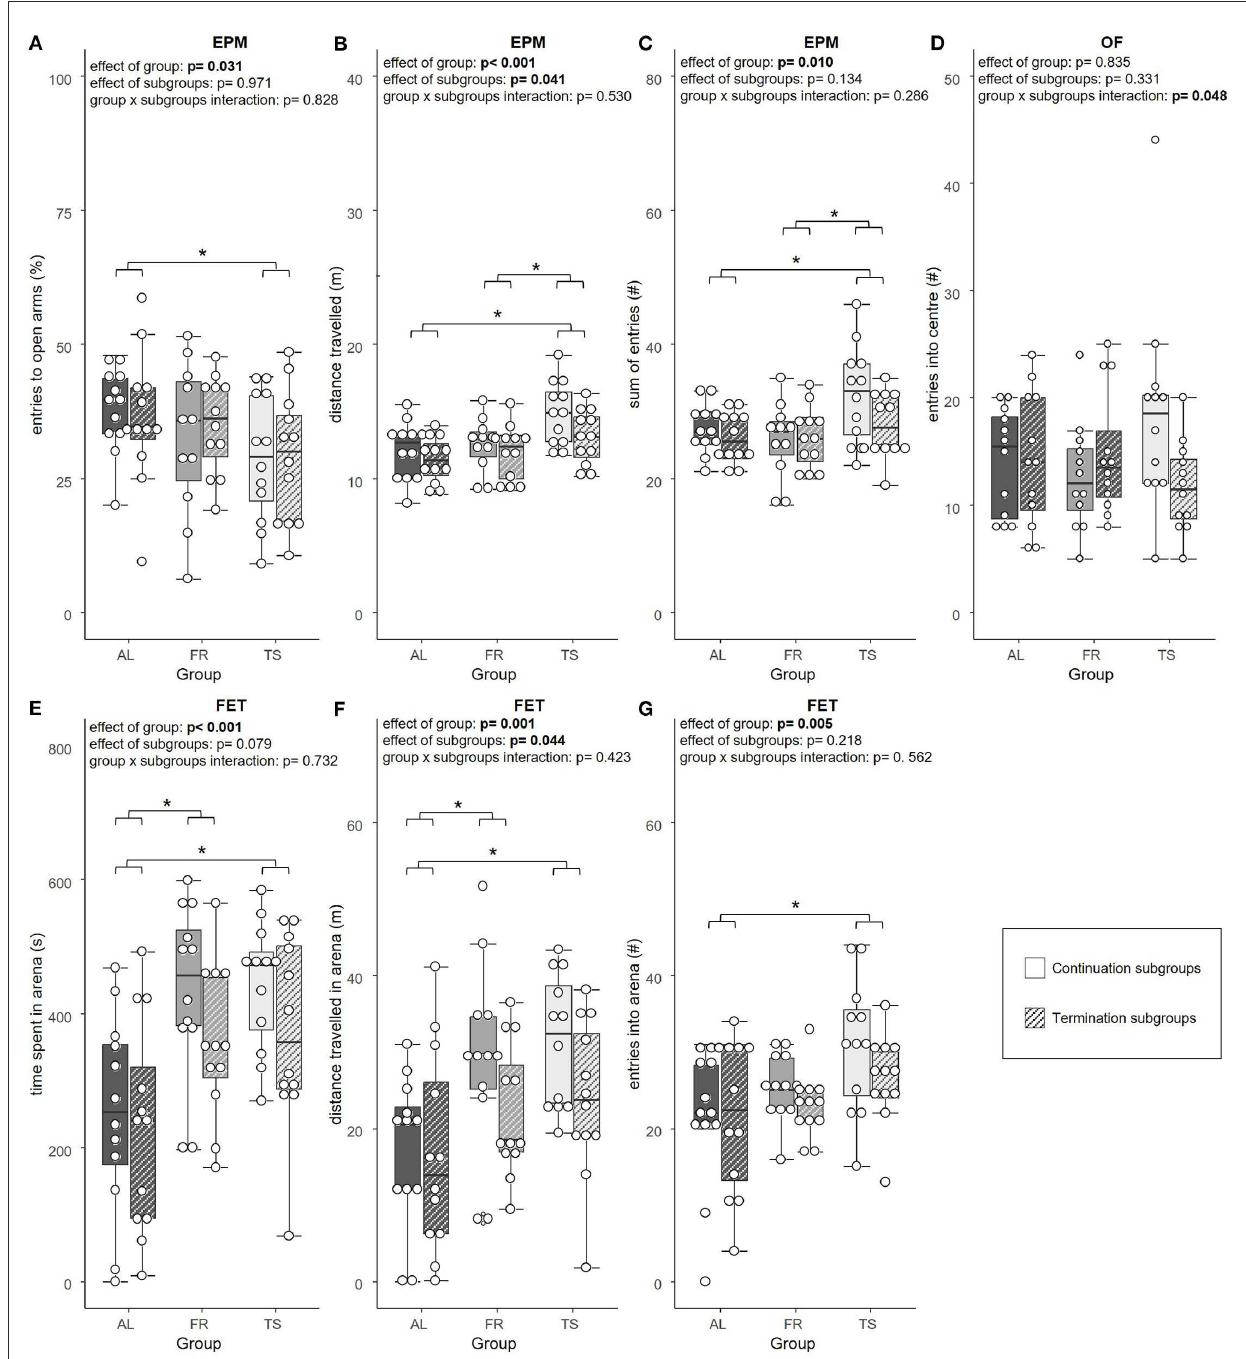
FIGURE3 Anxiety-like and exploratory behavior. (A) relative number of entries into the open arms of the Elevated plus maze test (EPM), (B) total distance traveled in the EPM, (C) sum of arm entries in the EPM, (D) number of entries into the center of the Open field test (OF), (E) time spent in the arena of the Free exploration test (FET), (F) total distance traveled in the arena of the FET, (G) number of entries into the arena of the FET. AL, ad libitum fed mice; FR, food restricted mice; TS, touchscreen trained mice. Sample sizes: n = 12/group. Exception: FR mice from continuation subgroups in A, where n = 11. Box plots show the median (lines in boxes), the 25 and 75% quartiles (boxes), the minima and maxima (whiskers) and individual data points (circles). Statistics: LMM. * p ≤ 0.05.